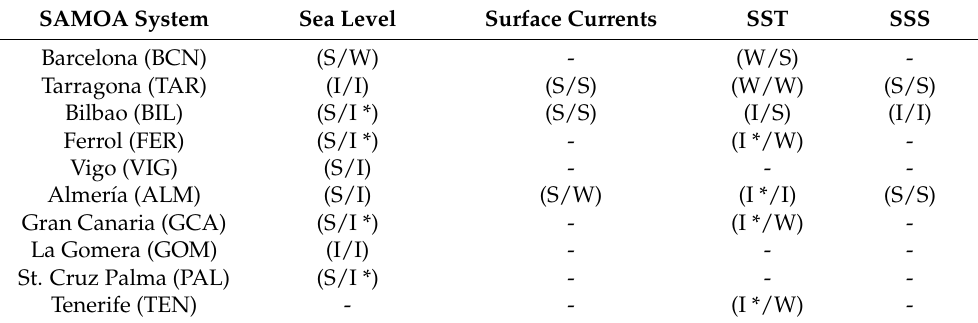
Table 6. Summary of the impacts of the SAM_ADV set-up. Performance of SAM_ADV versus the control (SAM_INI) one and the parent solution (IBI_PHY), comparing in those domains where observations are available (for sea level, SST, SSS and surface currents). Legend: (SAM_ADV relative performance with respect to SAM_INI set-up/SAM_ADV relative performance with respect to IBI_PHY). Acronyms to define the relative performance of the proposed set-up: (I *: relevant improvement/I: improvement/S: similar performance/W: mild worsening).